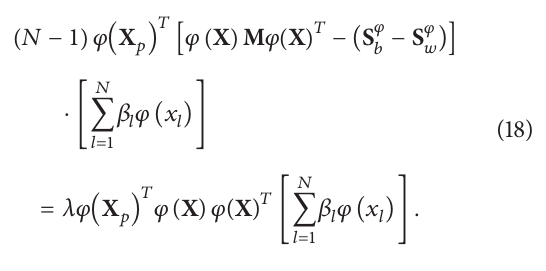
Table 5: Ratio of between-class distance and within-class distance using four dimensionality reduction methods. KPCA